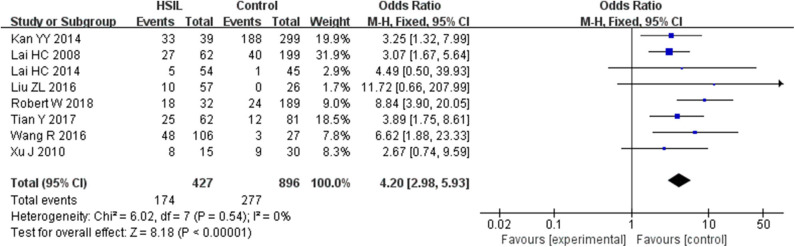
Forest plots for associations of SOX1 promoter hypermethylation with the risk of HSIL. The squares represent the ORs for individual studies. The size of the square reflects the weight of included studies. Bars represent the 95% confidence intervals (CIs). The center of the diamond represents the summary effect size. Abbreviations: HSIL, high-grade intra-epithelial lesion; ORs, odd ratios.